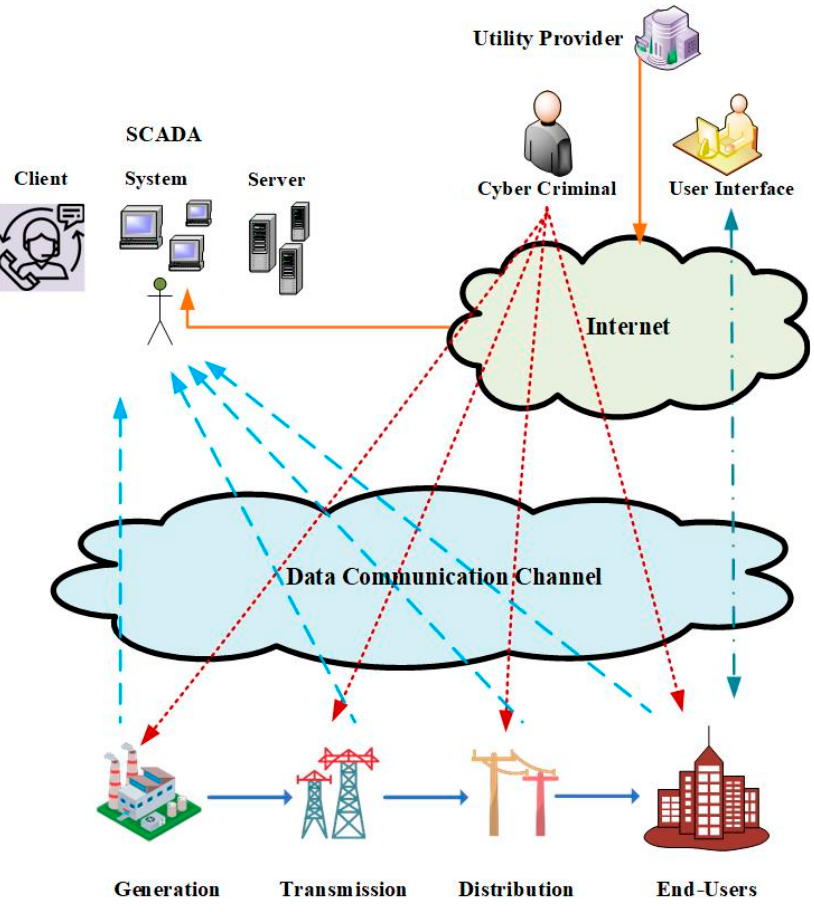
Figure 10. Different cyberattack approaches in IoT-enabled smart grids.